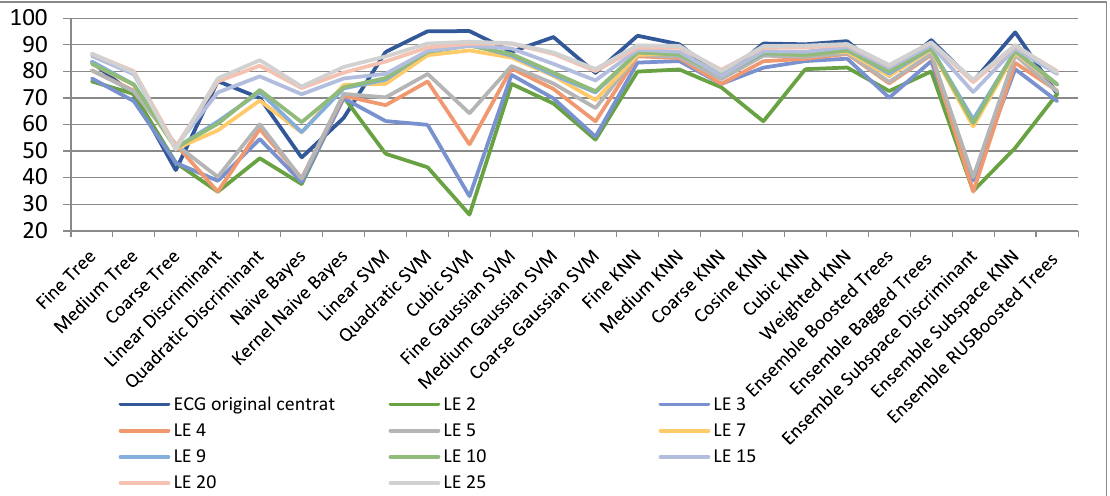
Figure 5. Classification results with LE method for dimensionality reduction. Table 3. Classification results with LE method for dimensionality